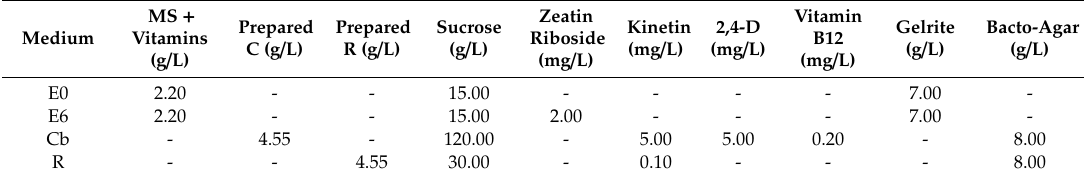
Table 1. Composition of the di ff erent culture media used in the androgenesis protocols of Phase 2. The table collects the information on concentrations of basal salts, carbon source, growth regulators and gelling agent for the preparation of media E0, E6, Cb and R. Preparations C and R are specific formulations previously described